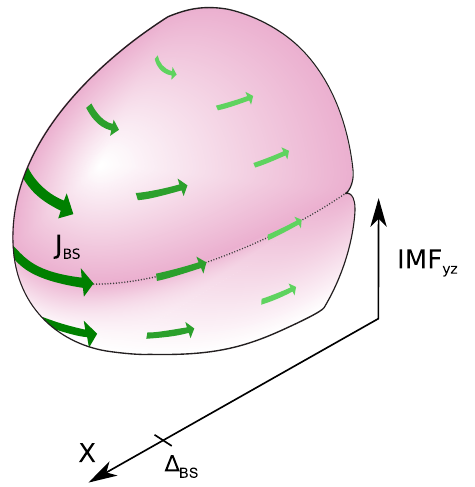
Figure 9. 3-D scheme of day-side bow shock current magnitude and orientation with respect to the IMF y − z component (GSM) in case of a quasi-perpendicular bow shock. Greater and darker arrows represent higher values of current